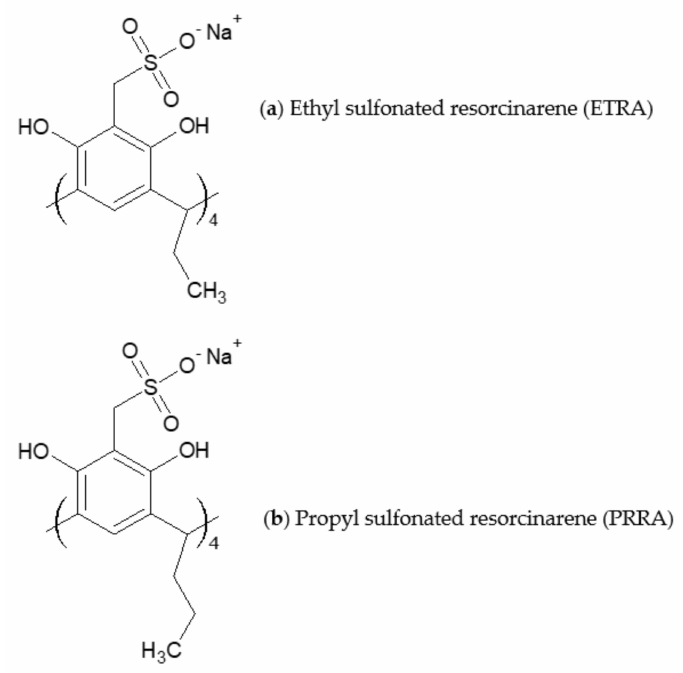
Figure 4. Molecular structures of the corresponding monomers of ( a ) tetrasodium 5,11,17,23-tetrakissulfonatemethylen-2,8,14,20-tetra(ethyl)resorcin[4]arene (ETRA) and ( b ) tetrasodium 5,11,17,23-tetrakissulfonatemethylen-2,8,14,20-tetra(propyl)resorcin[4]arene